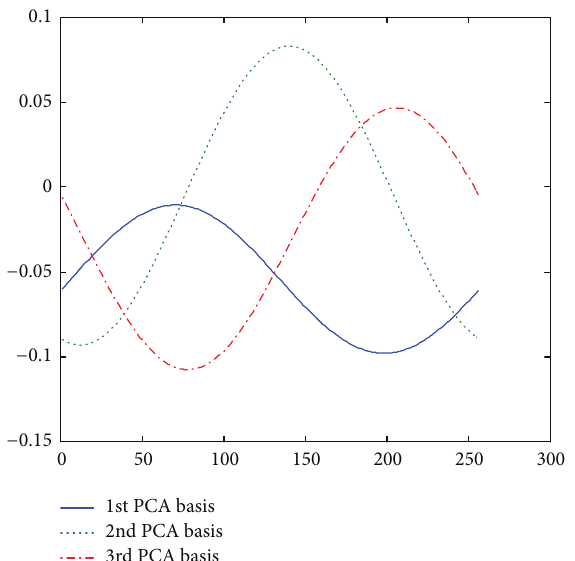
Figure 7: PCA bases of approximated LFE contours with 𝑚 value being